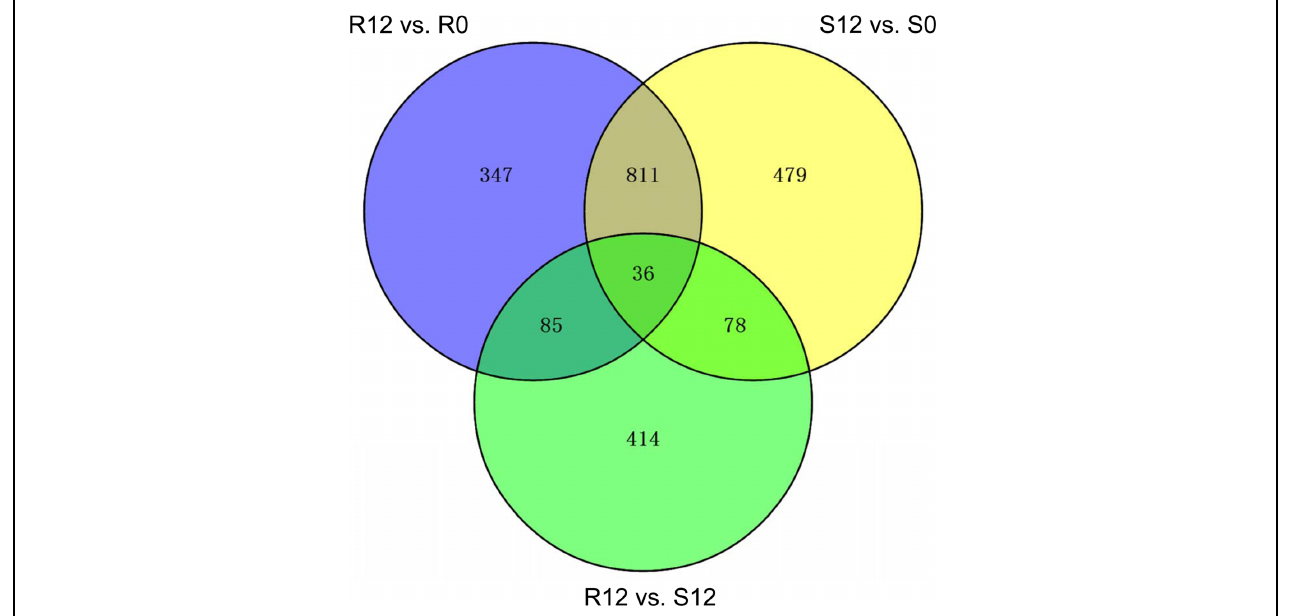
FIGURE 7 | Venn diagrams of differentially expressed genes (DEGs). The DEG sets (R12 vs. R0, S12 vs. S0 and R12 vs. S12) were analyzed using the Venn method. The numbers marked in the diagram indicate the number of genes significantly differentially expressed among the three DEG sets (log 2 -fold change > 1 or < –1 and P -value < 0.05). Eighty-five DEGs were defined as resistance-specific expressed genes (RSGs) in S1003, and 36 DEGs were defined as constitutively expressed genes (CEGs) in S1003 and NIL( Pm5.1